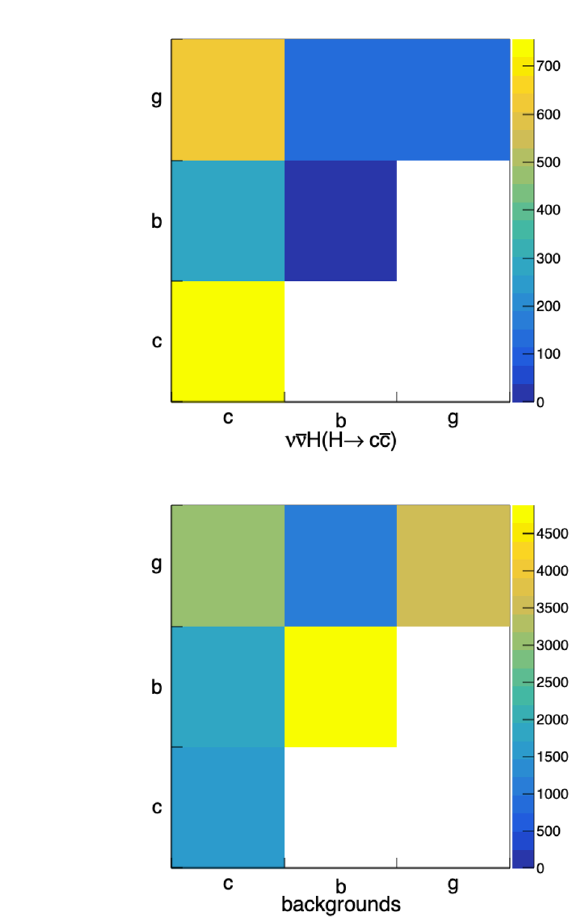
Figure 8 . The distributions of ν ¯ νH ( H → b (bottom left), and backgrounds (bottom right) based on the optimized flavor tagging performance